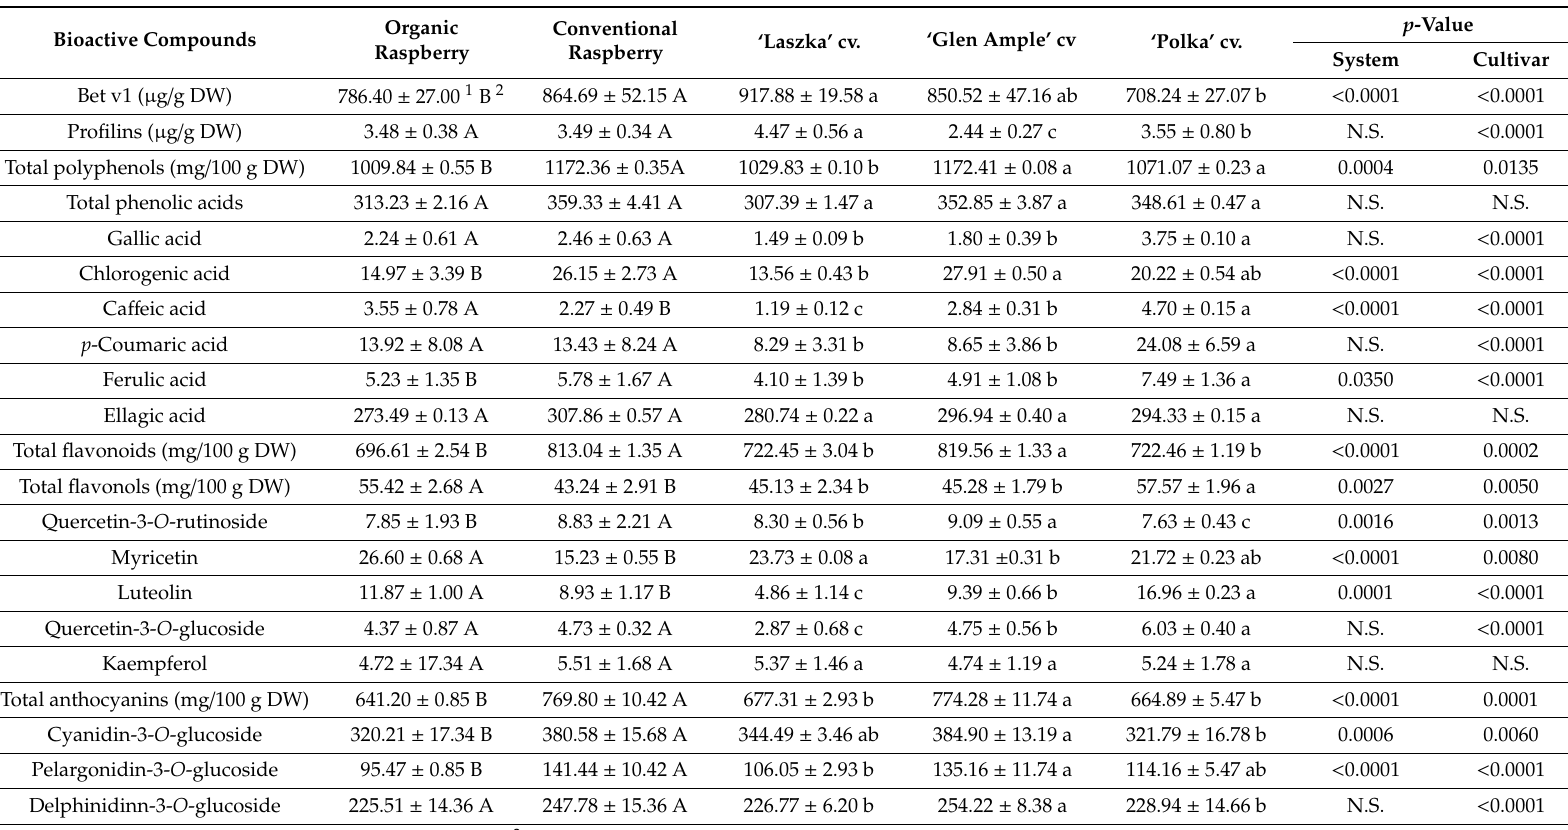
Table 2. The content of allergenic analogs and polyphenols in examined raspberry cultivars from organic and conventional farming system in